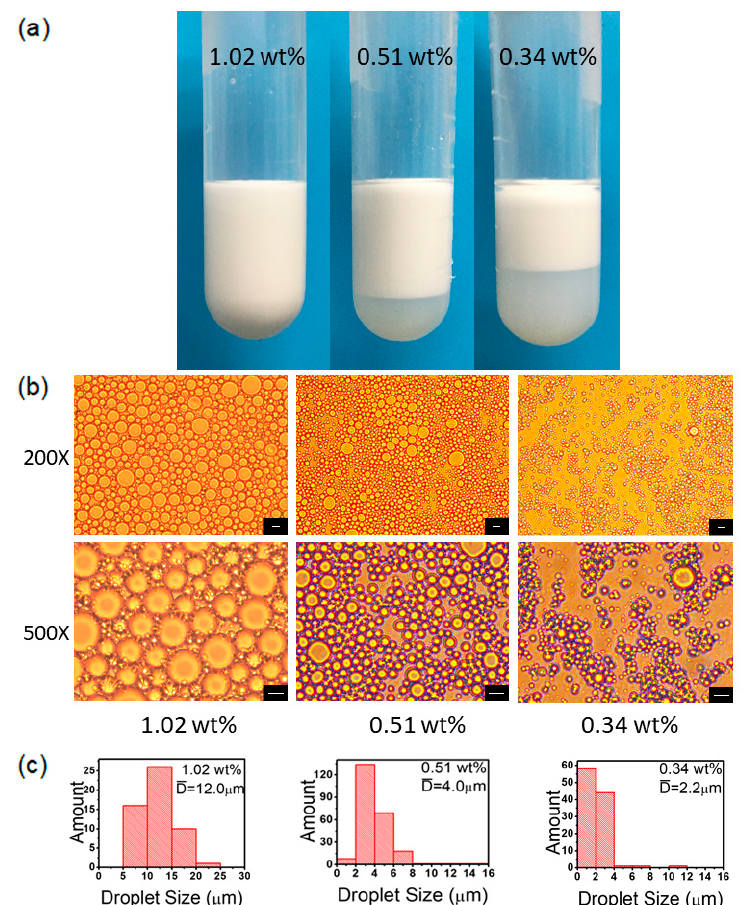
Figure 9. ( a ) Optical images of hexadecane/H 2 O Pickering emulsions stabilized by PS@PSS with different concentrations after standing for 10 min; ( b ) Microscope images of hexadecane/H 2 O Pickering emulsion stabilized by PS@PSS with different concentrations. Here the ultrasonic power is 150 W, salt concentration is 0.1 mM, ultrasonic time is 3 min, and water:oil ratio is 1:1. The bar is 10 μ m. ( c ) Droplets size distribution in number corresponding to microscope images.